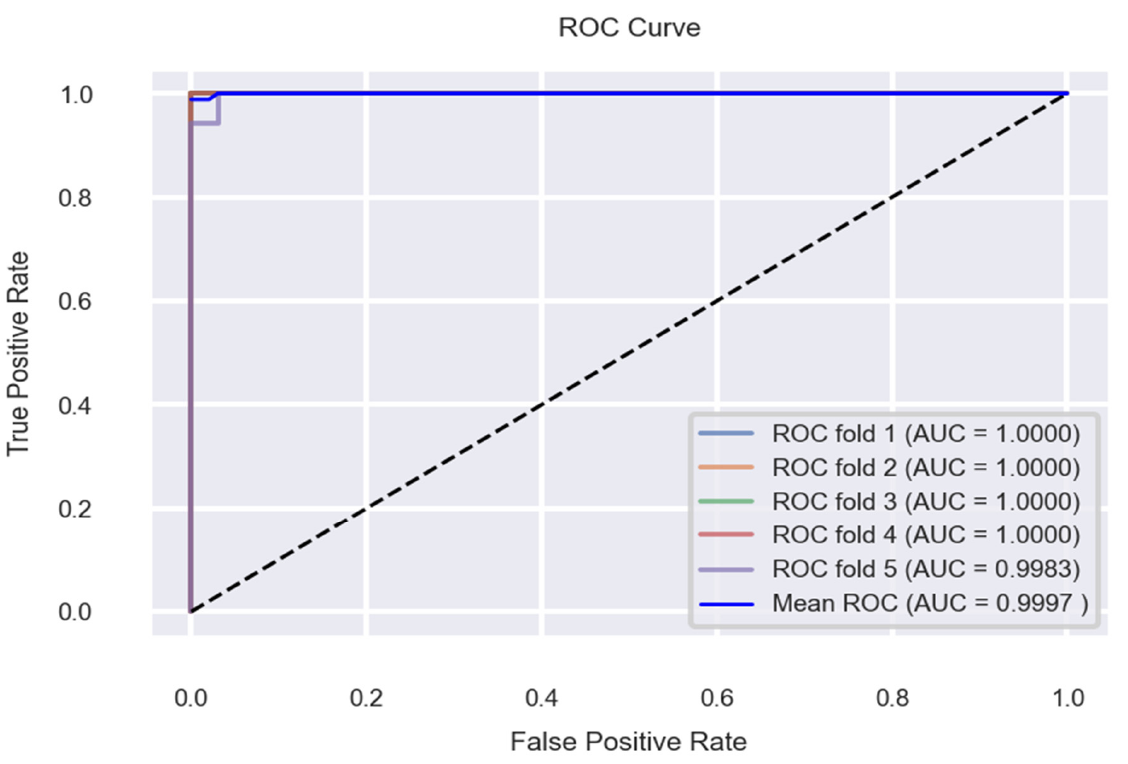
Figure 18. Stratified (K = 5)-Fold Cross-validation Results for Random Forest Classifier (ROC-AUC).